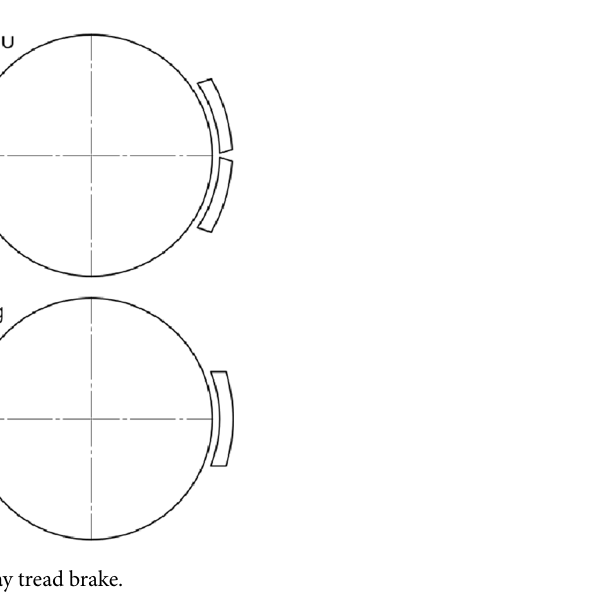
Figure 1. Photographs of the organic composite brake blocks after testing: ( a ) made of Material A; ( b ) made of Material B.